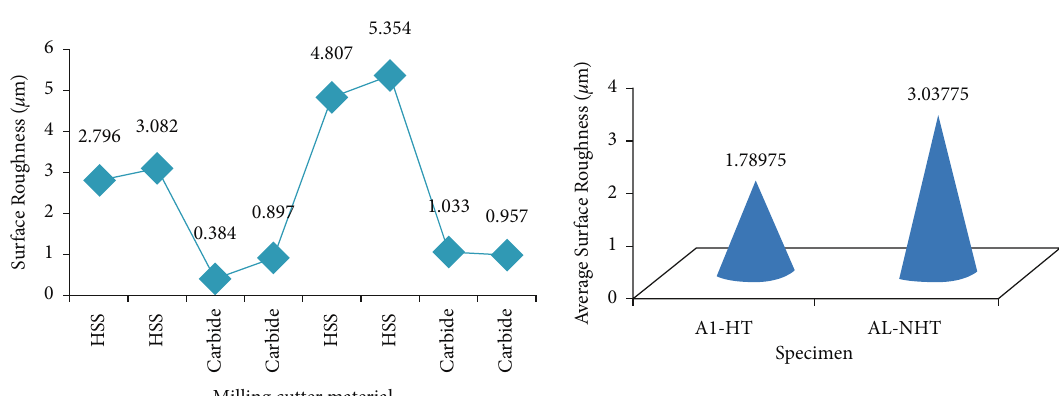
Figure 6: Variation of surface roughness by the DHT